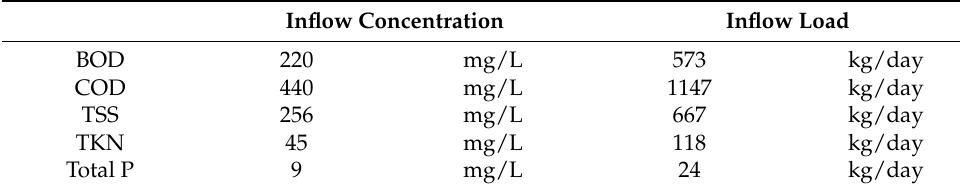
Table 1. Means of the multi-annual inflow concentration and load values. Inflow Concentration Inflow Load